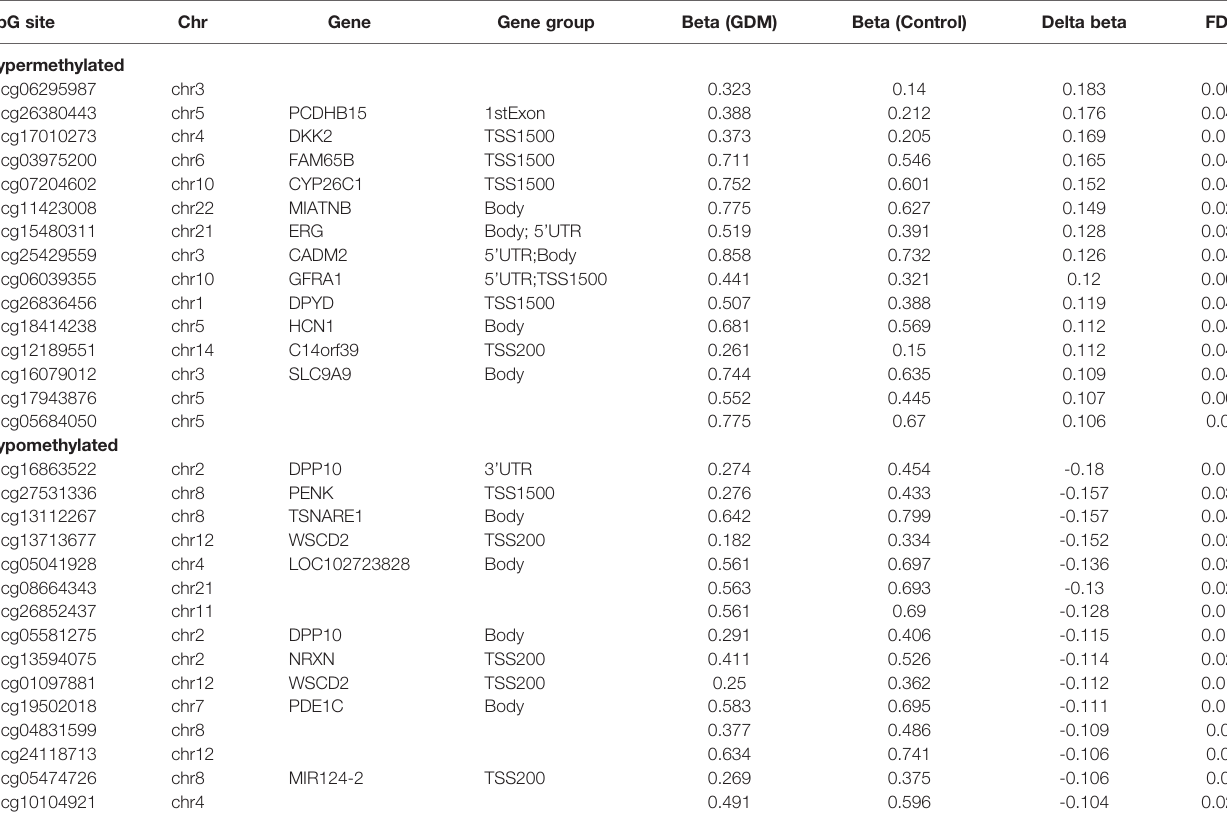
TABLE 2 | Top 30 differentially methylated positions (15 hypermethylated and 15 hypomethylated DMPs) in placental DNAs in GDM vs. euglycemic (control) groups.